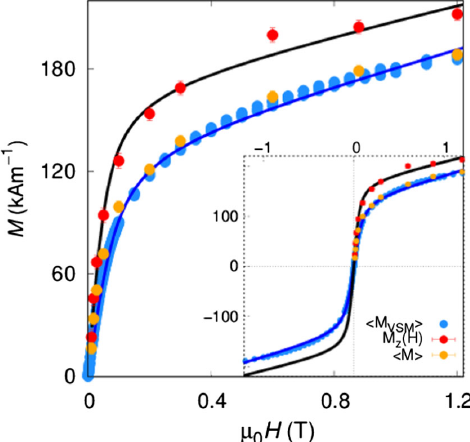
FIG. 5. Macroscopic longitudinal magnetization ( h M measured at room temperature in comparison with the longi- tudinal particle core magnetization [ M volume averaged magnetization ( h M i ), both derived from SANS- POL. Corresponding fits are shown as lines. Inset: Full data range for h M VSM i